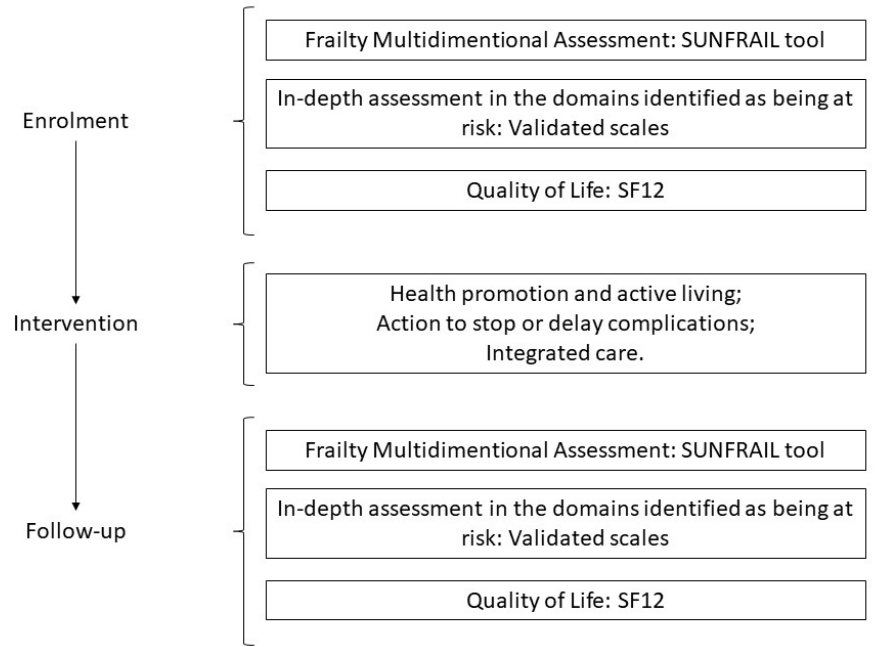
Figure 3. SUNFRAIL+ study design and planned intervention.